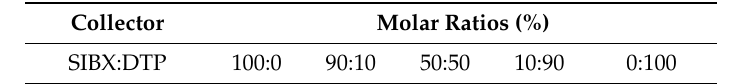
Table 2. SIBX-SEDTP recipes in % molar ratios used for a total collector dosage of 150 g / t.